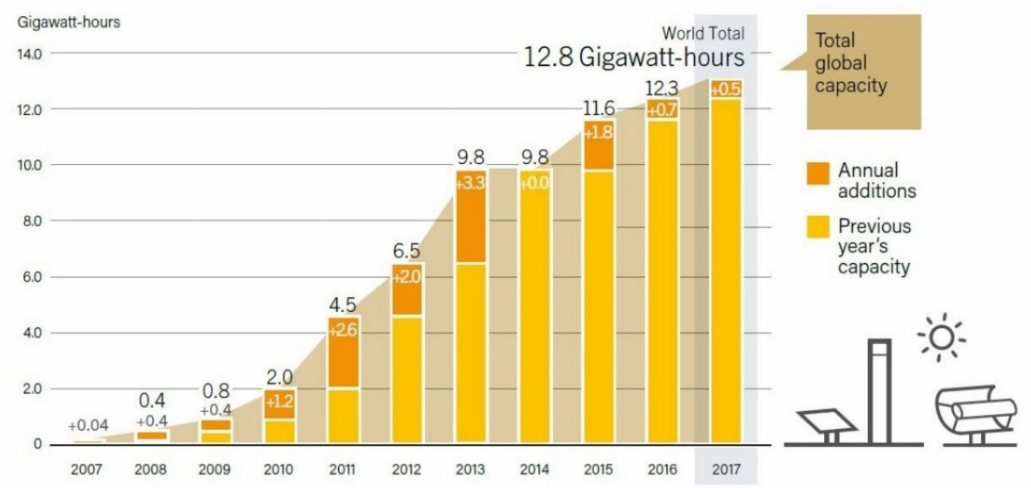
Figure 8. CSP thermal energy storage global capacity and annual additions, 2007–2017